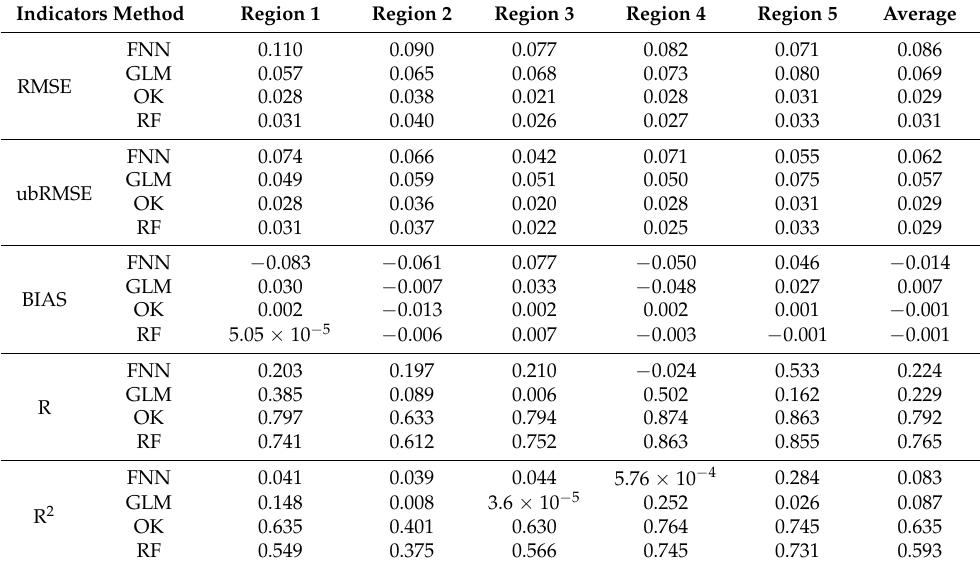
Figure 7. Scatterplots between the gap-filled SM and the original ESA CCI SM over the five simulated data gaps. Region 1–5 was symbolized by 1–5 in sequence and FNN, GLM, OK, RF was symbolized by ( a – d ) in sequence. Table 2. The statistics of R, R 2 , RMSE, ubRMSE, and BIAS between simulated data and ESA CCI data in the 5 regions.